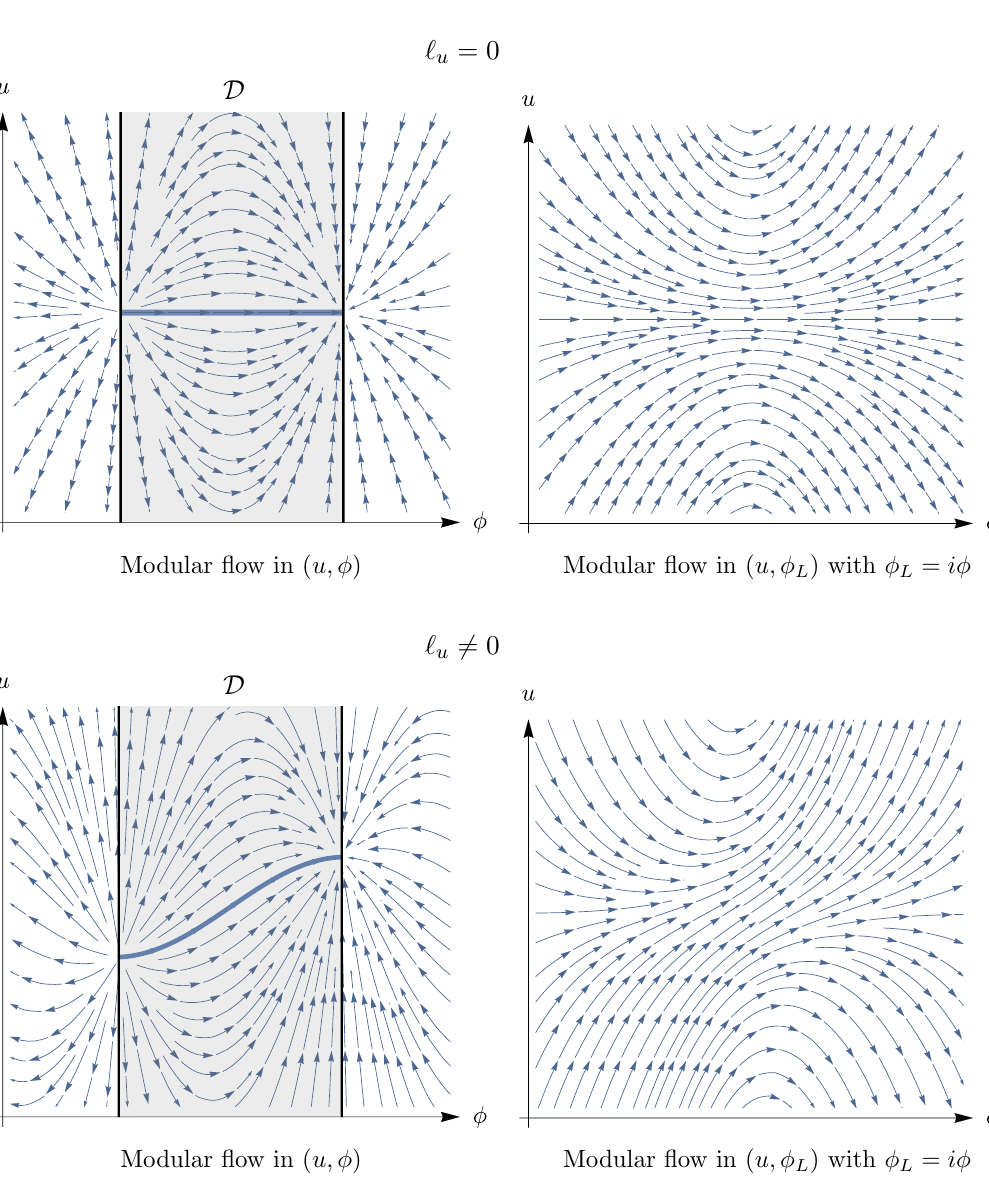
Figure 2 . Boundary modular (cid:13)ow for 3d Minkowski. The left pictures represents the modular (cid:13)ow with the entangling region A (in blue) and its domain of dependence D (shaded) for ‘ u = 0 and ‘ u 6 = 0. The right picture is the Wick rotated version with (cid:30) L = i(cid:30) , where we see that the modular (cid:13)ow circles around a point at in(cid:12)nity. In contrast with the corresponding AdS/CFT picture (which is (cid:12)gure 2 in [20]), the modular (cid:13)ow does not \transport" the entangling region A but is